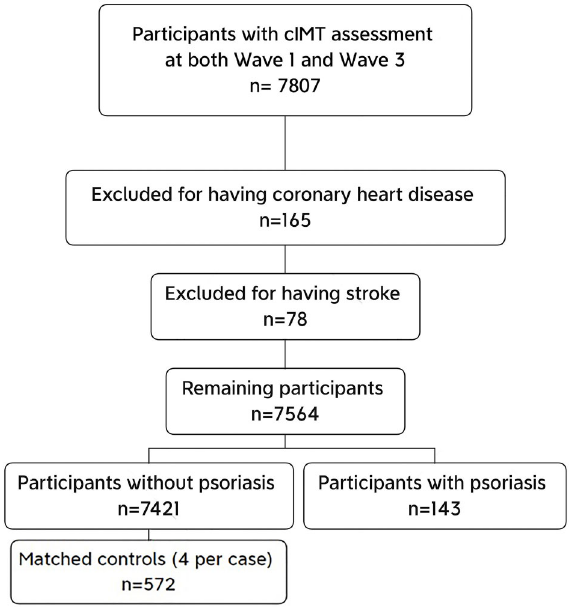
Figure 1. Flowchart of the sampling process. CIMT: Carotid intima-media